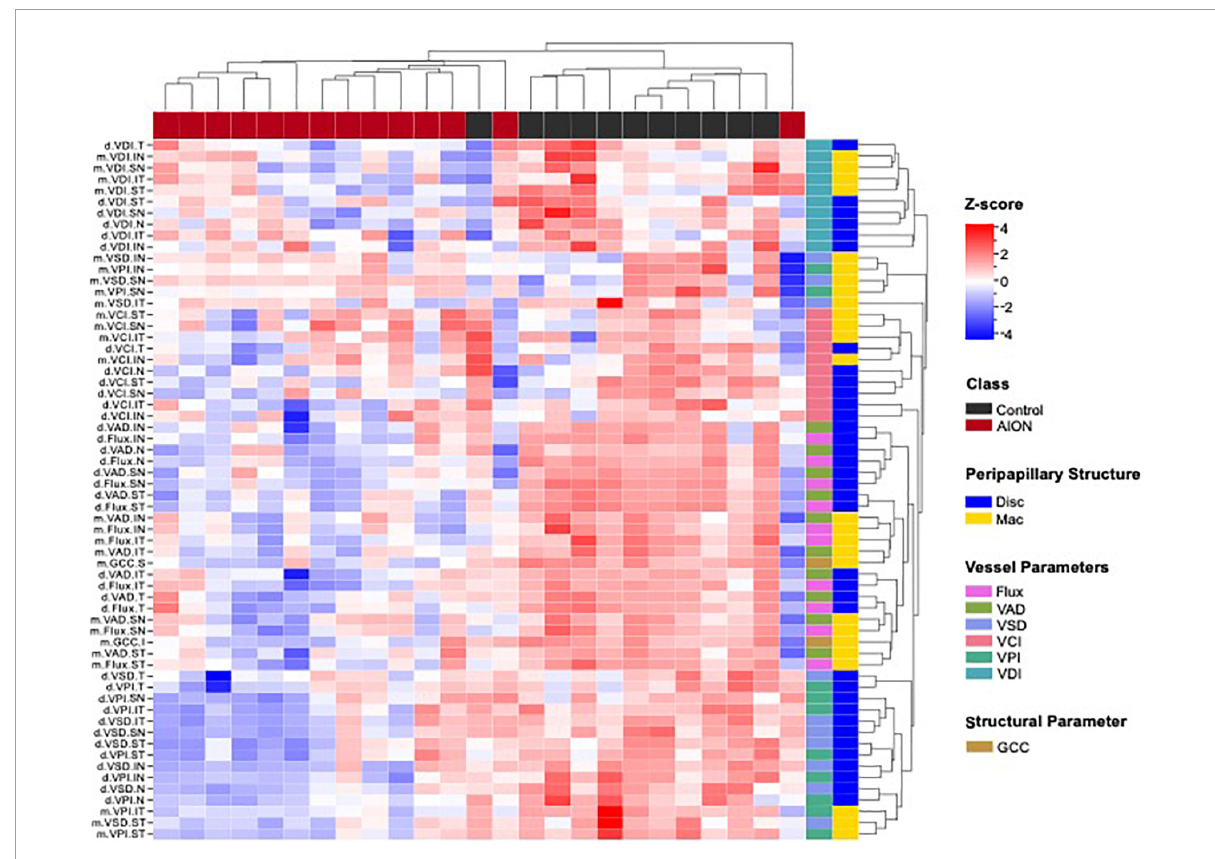
FIGURE4 Hierarchical clustering of optic disk and macular optical coherence tomography (OCT) and optical coherence tomography angiography (OCTA) measurement (vertical dendrogram) for all eyes (horizontal dendrogram) showed that data clustered into two distinct groups. Cluster map shows that patients generally showed lower values for each measurement as compared to controls, which corresponds to the deterioration of retinal structure. In the annotation to the right of the heatmap, the colors are defined by the legends on the far right. Disk, optic disk; GCC, ganglion cell complex; Mac, macular; VAD, vessel area density; VCI, vessel complexity index; VD, vessel diameter; VPI, vessel perimeter index; VSD, vessel skeleton